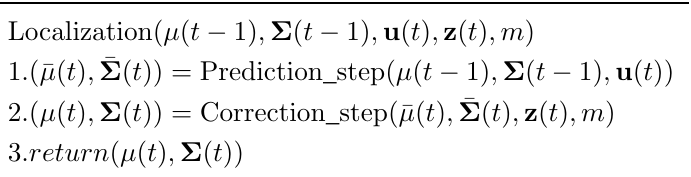
Table 1. Localization